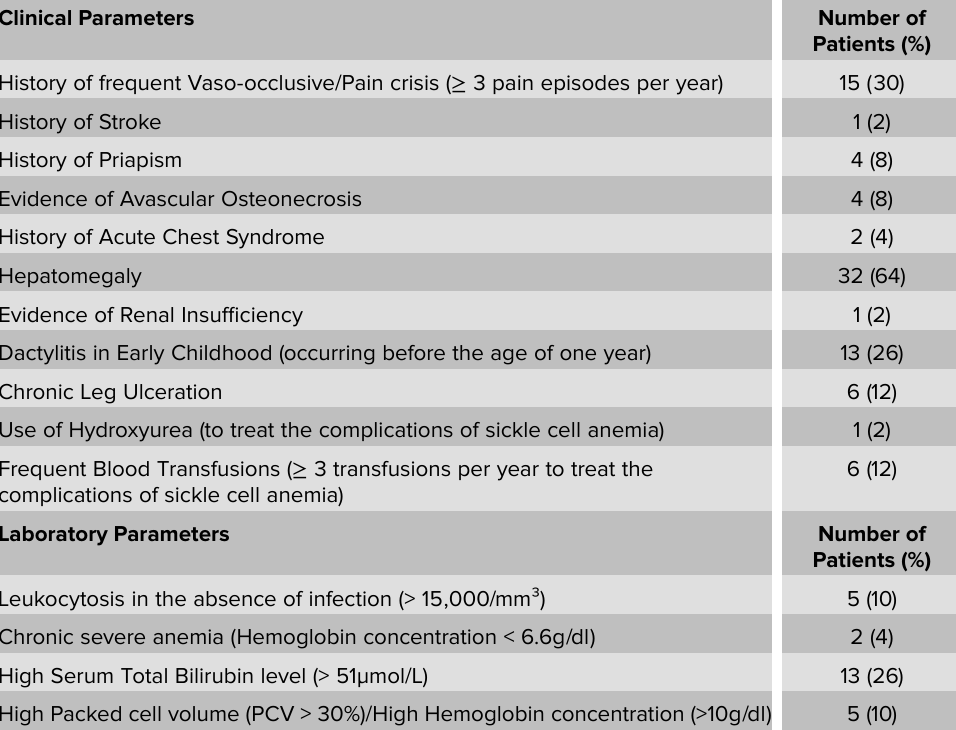
Table 4: Frequency of the indices of disease severity identified in the sickle cell anemia patients. Clinical Parameters Number of